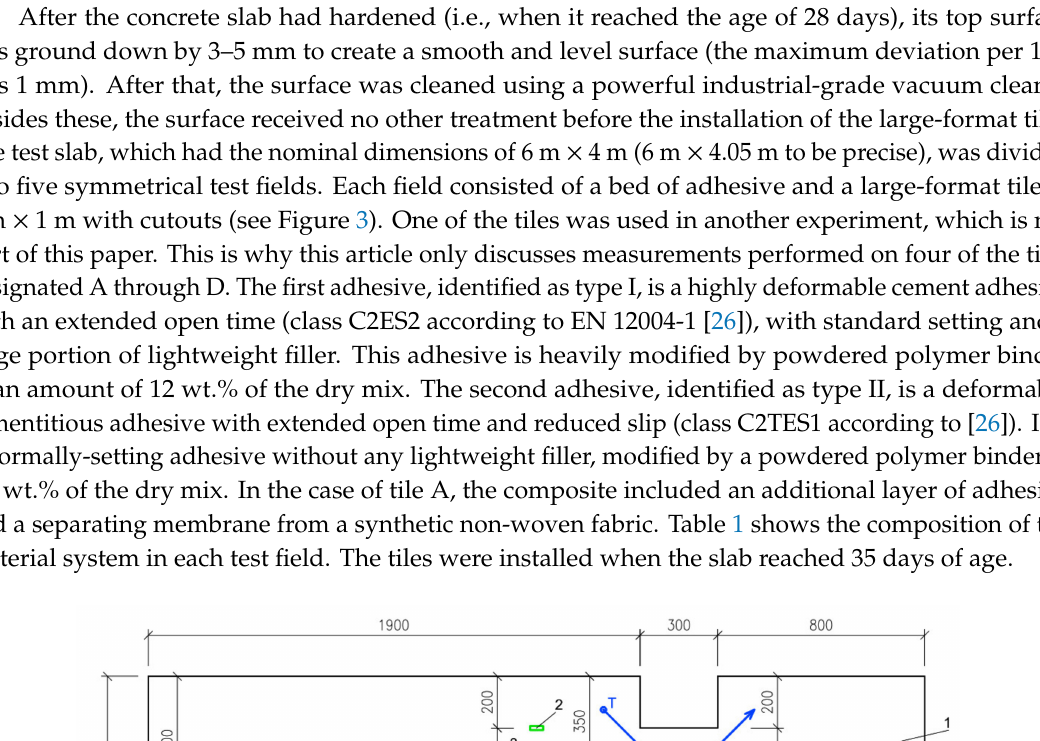
Figure 2. Structure and distribution of the reinforcement.